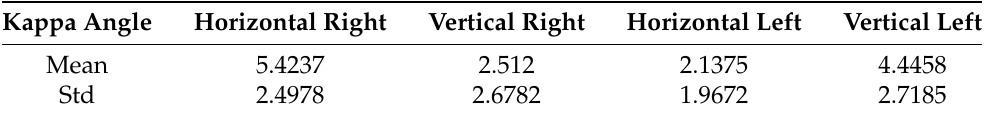
Table 1. Visual axis vertical and horizontal tilts (in